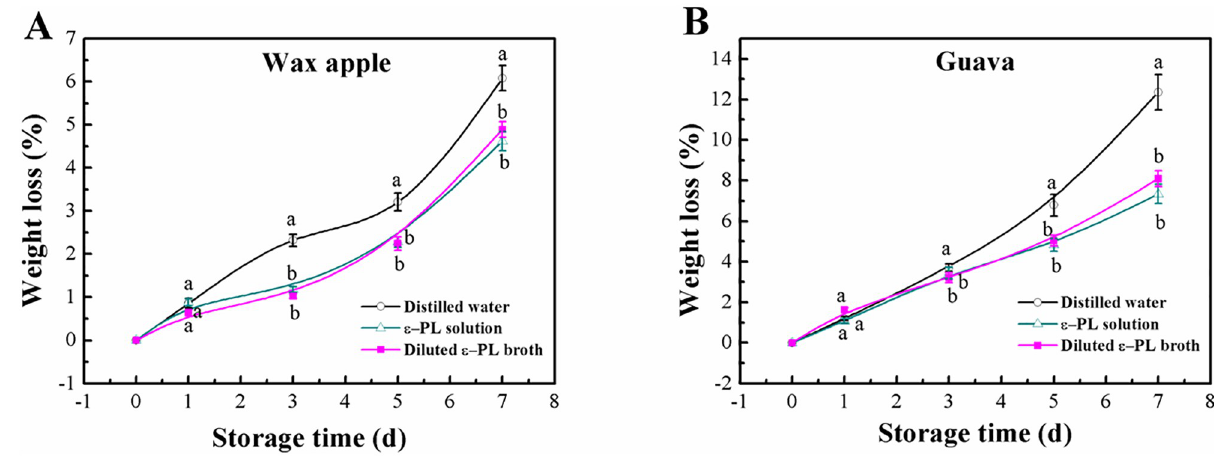
Fig 3. Changes in weight loss of wax apple and guava fruits with different treatments during postharvest storage. Different letters at the same time point indicate significant differences at P < 0.05. Vertical bars represent standard deviations of the means (n = 3).